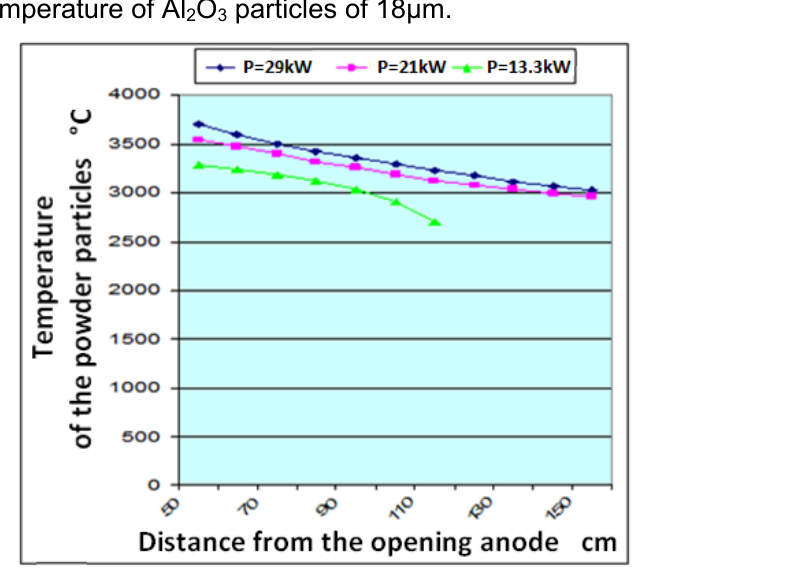
Figure 5 – Effect of the plasma gun power supply on the surface temperature of Al 2 O 3